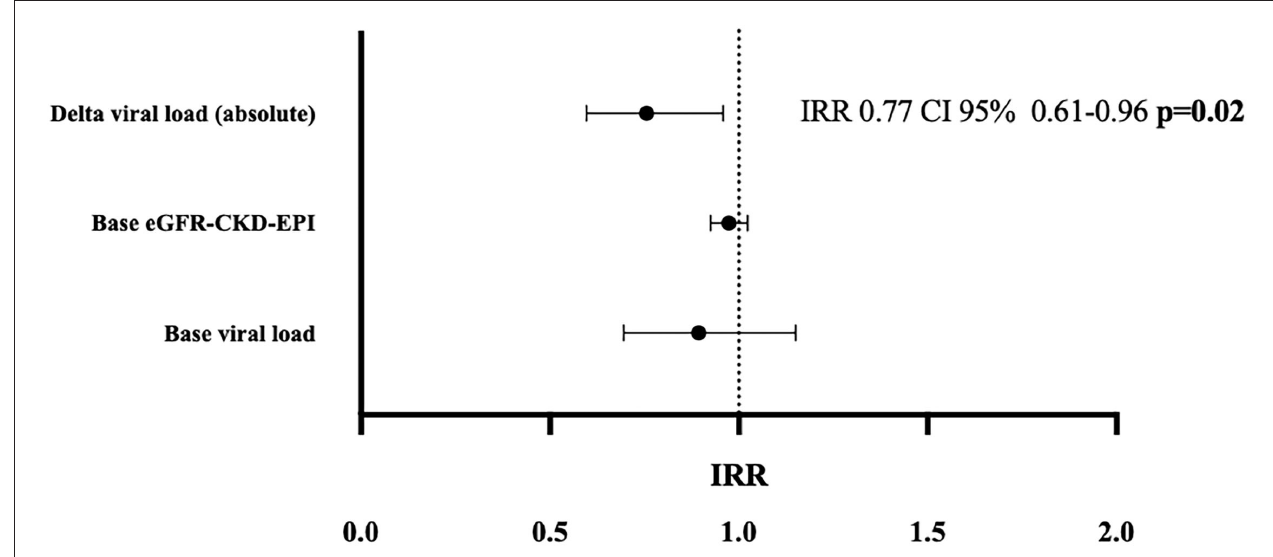
FIGURE 3 | Multivariable Poisson regression model; shows the incidence rate ratios ( IRR s) for death censored graft loss after 2 years for absolute viral load changes corrected for the baseline eGFR and baseline viral load at biopsy. Absolute delta viral load over 24 months was assessed between months 0–1, 1–3, 3–6, 6–12, and 12–24. Poisson models for estimation of IRR with 95% CI s; eGFR-CKD-EPI: estimated glomerular filtration rate measured by the CKD-EPI equation, base viral load: BK-Virus viral load in plasma at the time of